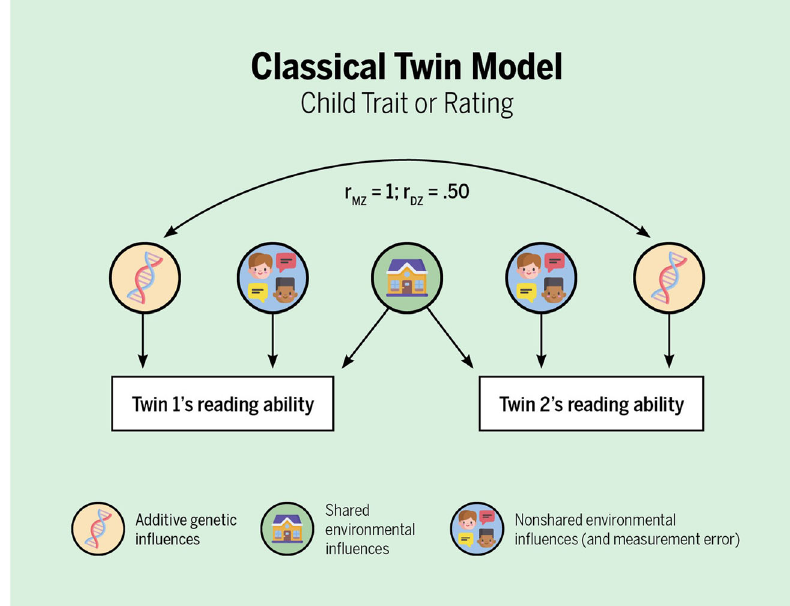
Fig. 4 Simpli fi ed representation of the classical twin model. In behavioral-genetic models, the three sources of in fl uences on individual differences are commonly labeled by the letters A, C, and E, respectively, stemming from A dditive genetic in fl uences (also known as heritability, and sometimes represented by an h 2 instead on an A), C ommon environmental in fl uences (also known as shared environmental in fl uences), and non-shared E nvironmental in fl uences (and measurement E rror). Note that the latter are by de fi nition uncorrelated between twins. See for a detailed representation of the classical twin model, for example, Figure A.9 in ref. 23 ; r MZ = monozygotic twin correlation; r DZ = dizygotic twin correlation. Figure by ref. 66 available at https://bit.ly/2Xkr29P under a CC BY 4.0